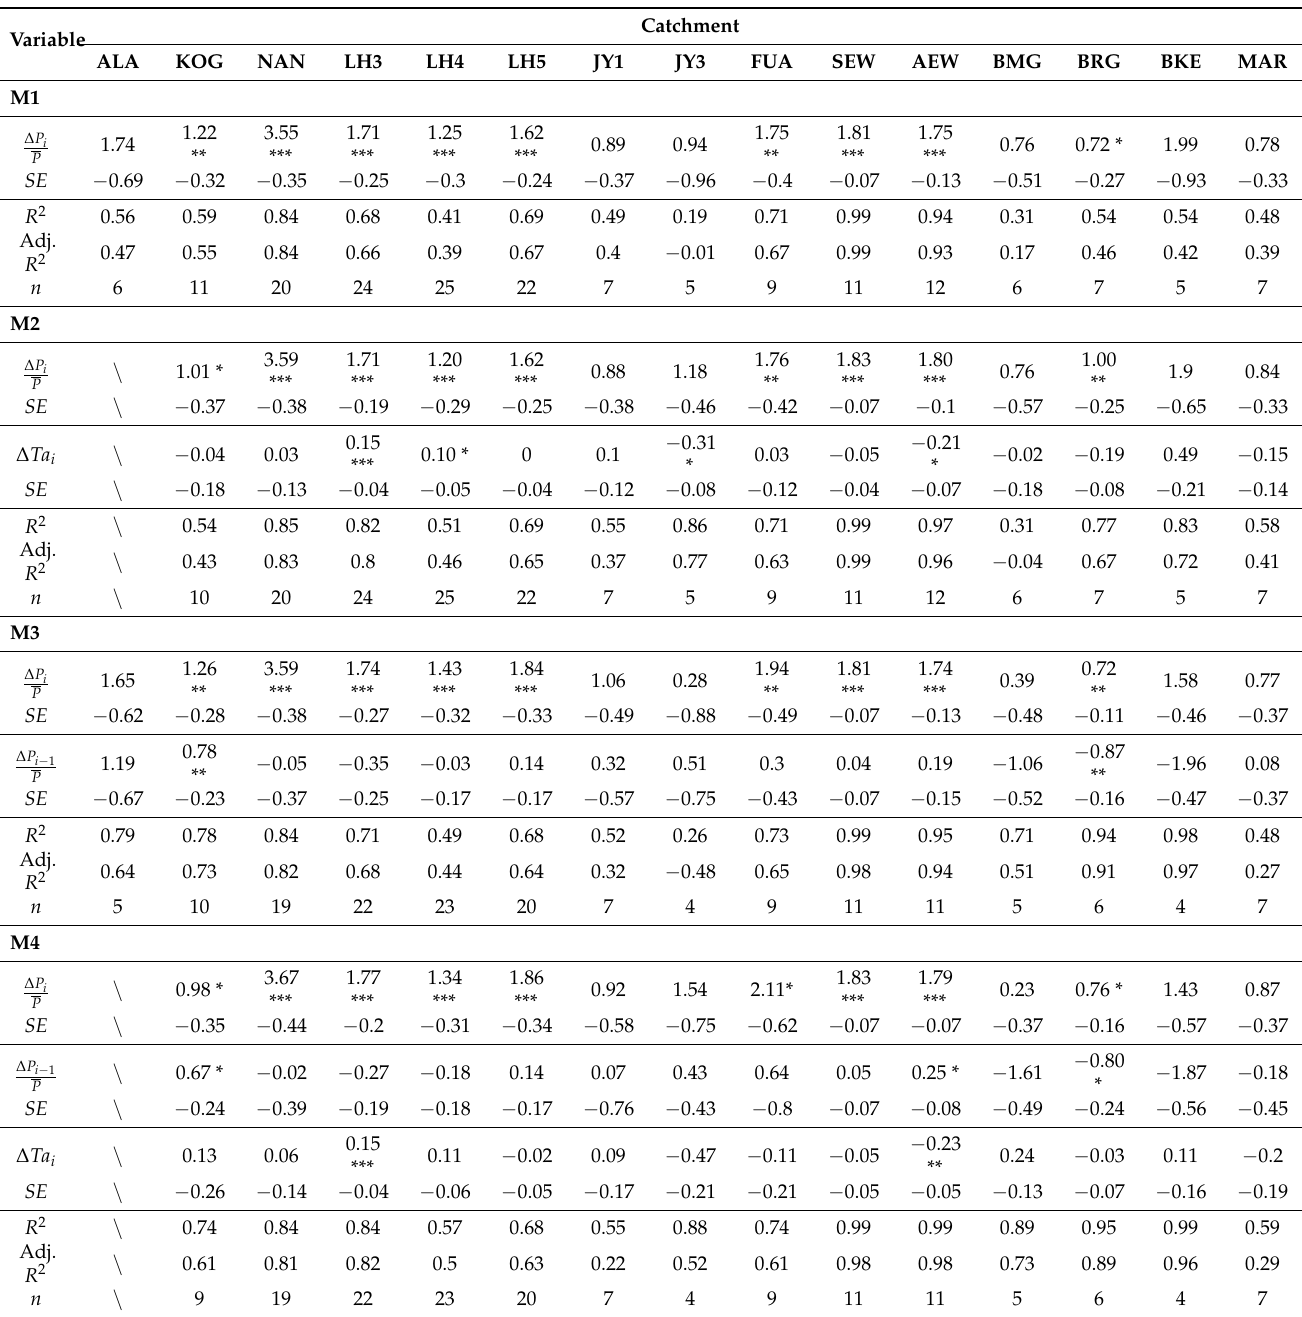
∆ R Table A1. Regression coefficients between i and various climatic variables ( R the M1, M2, M3, and M4 regressions, respectively. SE = standard error; n = sample size. Asterisks show significance level (*** p < 0.0001; ** p < 0.001; * p < 0.05). In most cases, simpler two-, and three-variable regressions are sufficient to derive climate elasticity of runoff, especially the traditional rainfall elasticity of runoff ( ε P ). However, the aim of this study was to determine climatic variables R that may affect climate elasticity; therefore, the multi-variable regressions were shown and discussed in the main